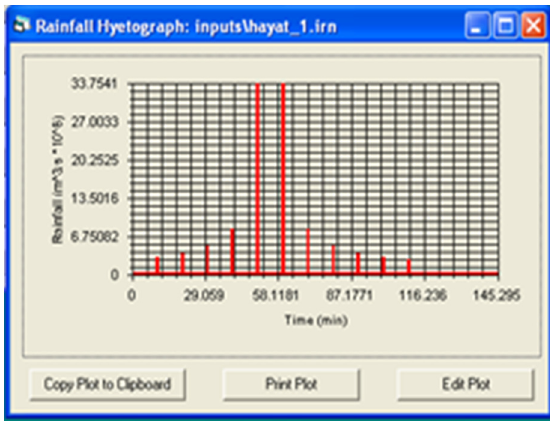
Fig. 3. Hyetograph of the case study.